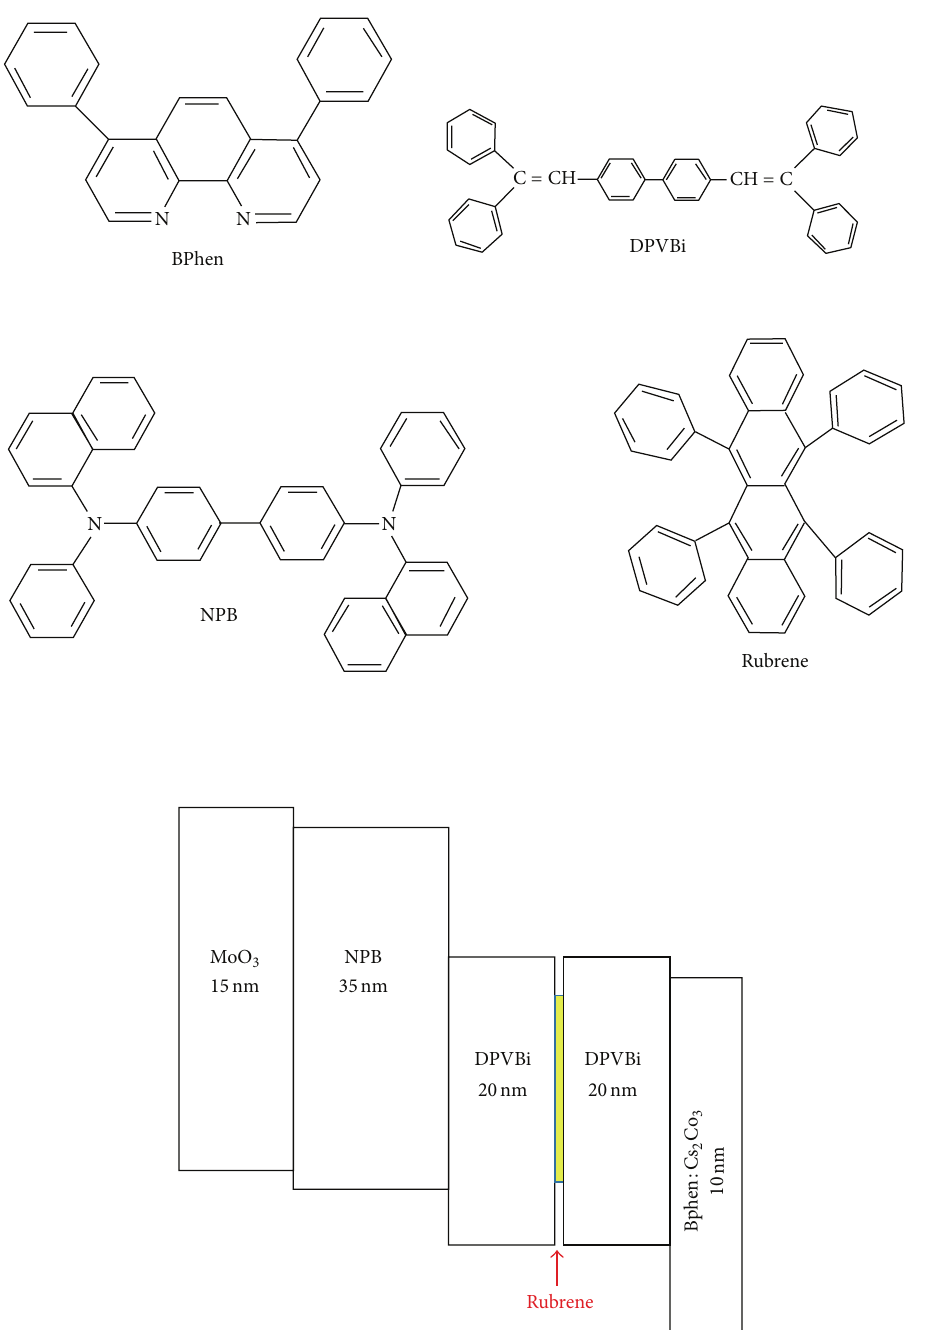
Figure 1: The chemical structures of organic materials and the structures of the device in the energy band diagrams of the multilayer (Rubrene = 0.1, 0.2 and 0.3 nm) for